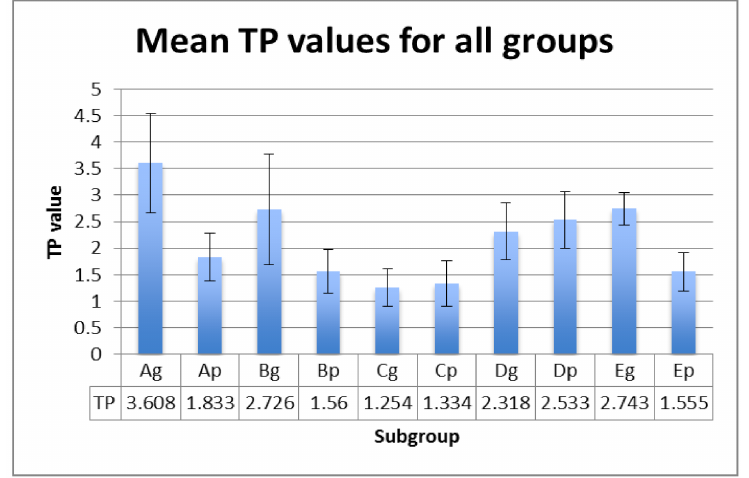
Figure 1. TP values (mean ± SD) for all tested